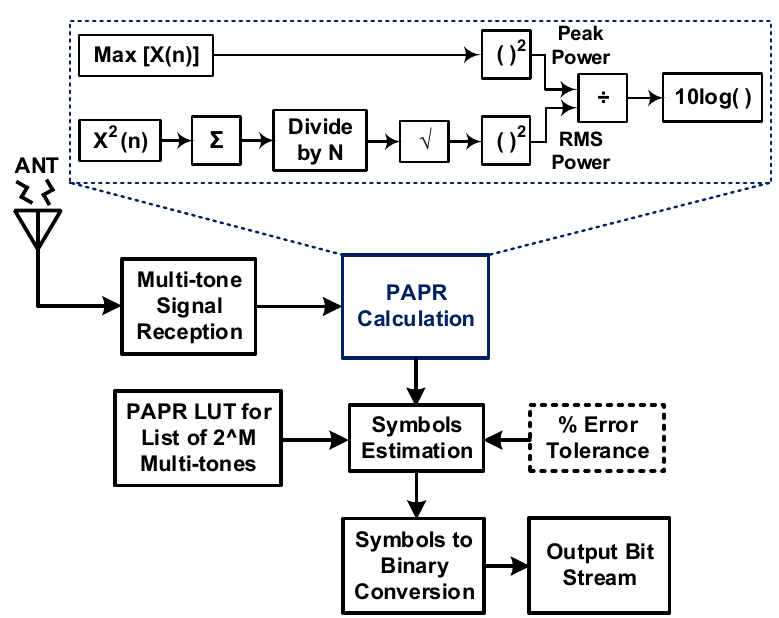
Figure 8. Block diagram of the proposed peak-to-average power ratio (PAPR) path.